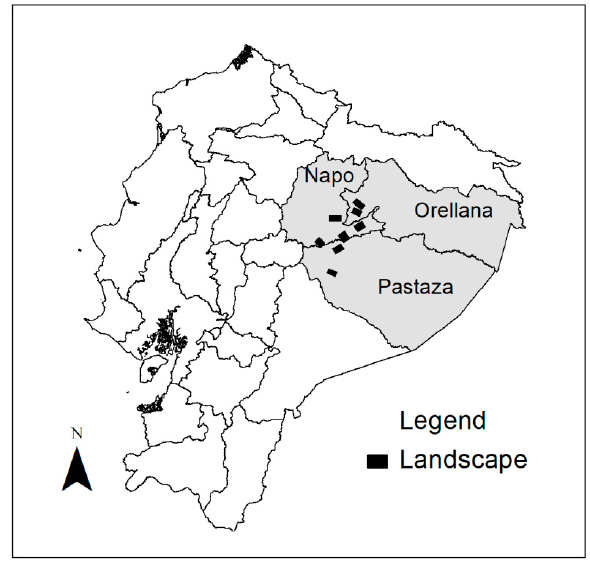
Figure 1. Selected landscapes in Ecuadorian Amazon region.